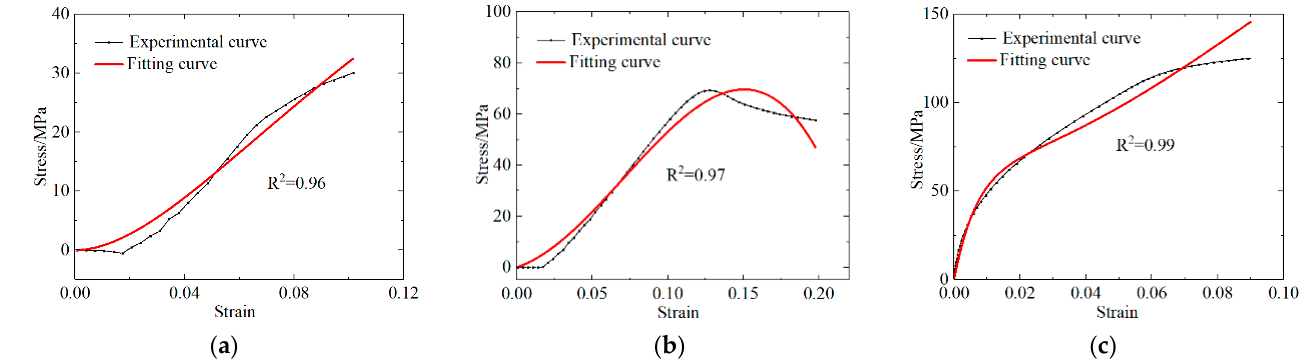
Figure 12. Comparison of PLA experimental curve and fitting curve. ( a ) Low strain rate stress difference; ( b ) low strain rate; ( c ) high strain rate.